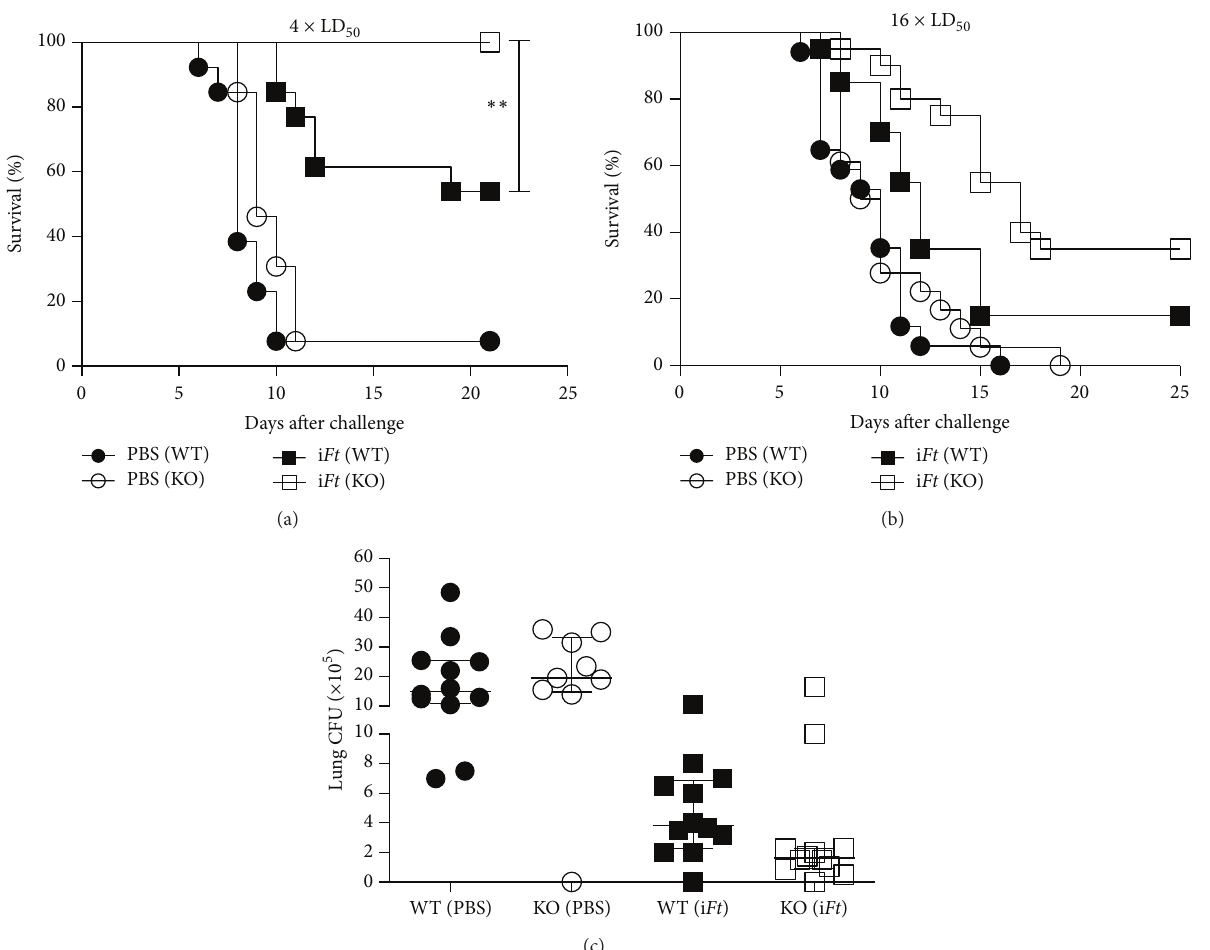
Figure 3: i Ft -immunized Fc 𝛾 RIIB KO mice exhibit increased protection against a lethal Ft -LVS challenge as compared to their WT counterparts. WT C57BL/6J and Fc 𝛾 RIIB KO mice were immunized i.n. with 20 𝜇 L of PBS (vehicle) or 2 × 10 7 i Ft -organisms in 20 𝜇 L of PBS on day 0 and boosted on day 21. On day 35 mice were challenged i.n. with approximately 4 × LD 50 (a) or 16 × LD 50 (b) of Ft -LVS. Survival was then monitored for 21 to 25 days. Panel (a) represents between 12 and 14 mice/group while panel (b) represents between 17 and 20 mice/group. Statistical analysis was determined by a contingency table analysis and two-tailed Fisher’s exact test on survival at day 21. ∗∗ 𝑃 < 0.01 . In addition, bacterial burden in the lungs of challenged mice was also determined. WT C57BL/6J and Fc 𝛾 RIIB KO mice were immunized i.n. with 20 𝜇 L of PBS (vehicle) or 2 × 10 7 i Ft -organisms in 20 𝜇 L of PBS on day 0 and boosted on day 21. On day 35 mice were given a sublethal challenge i.n. with approximately 0.4 × LD 50 of Ft -LVS. Five days after challenge lungs were collected, homogenized, and plated on chocolate agar to determine bacterial burden as described in Section 2. Each symbol represents a single mouse. Statistical analysis of the tissue bacterial burden was done via a nonparametric one-way ANOVA (Kruskal-Wallis test) coupled with a Dunn’s multiple comparison after test. While there appeared to be a substantial reduction in bacterial burden in the majority of i Ft -immunized Fc 𝛾 RIIB KO versus WT mice, the difference was not significant based on this